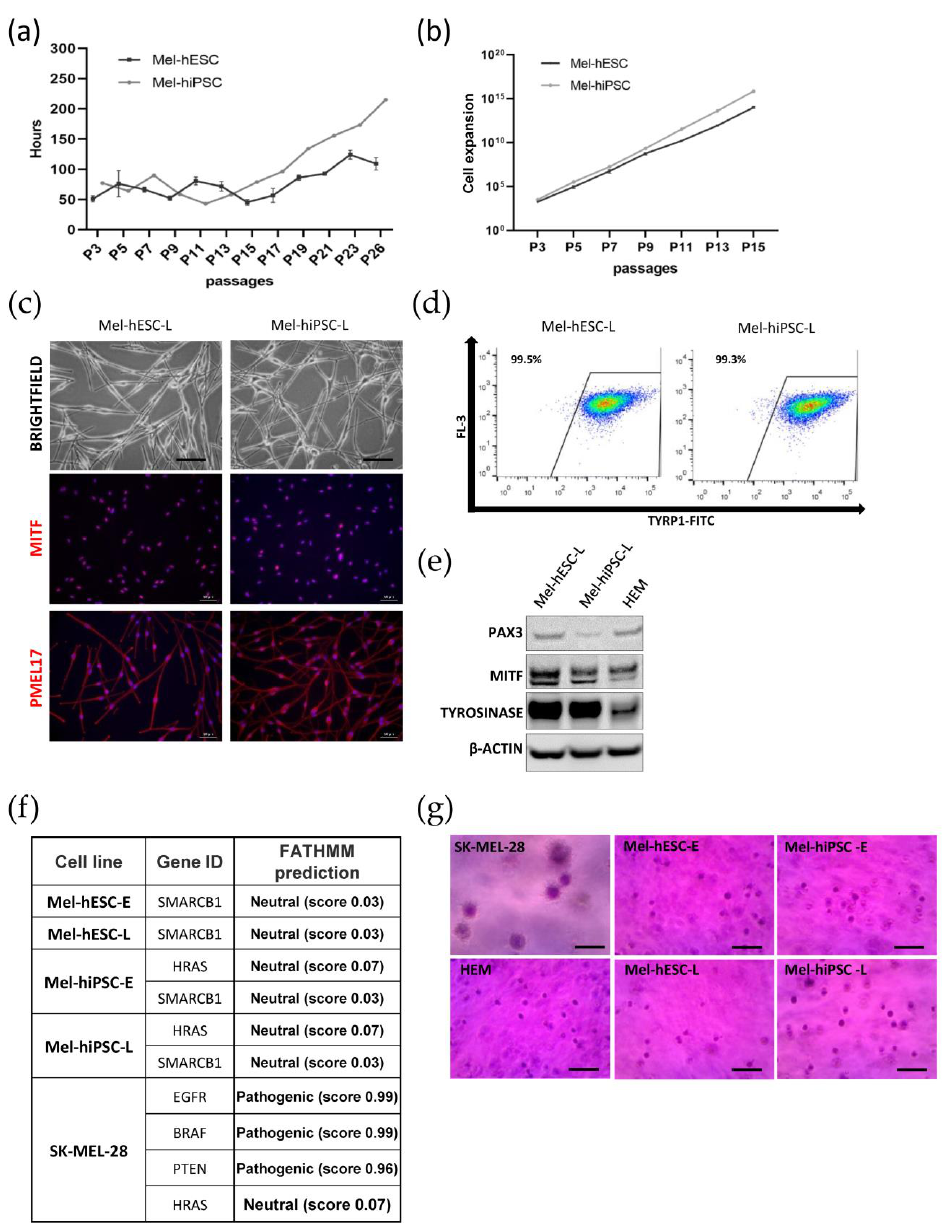
Figure 3. Long-term proliferation of hPSC-derived melanocytes. ( a ) Doubling time measurements during the growing phase of the Mel-hESC and Mel-hiPSC, from passage 3 (P3) to passage 26 (P26). ( b ) Cumulated cell expansion calculated from passage 3 (P3) to passage 15 (P15). For the next parts of the figure, Mel-hPSC early passages (Mel-hPSC-E) are defined from P3 to P15 and Mel-hPSC late passages (Mel-hPSC-L) are defined from P15 to P26. ( c ) Microscopy analysis and immunofluores- cence analysis of MITF, TYRP1, and PMEL17 in Mel-hESC-L and Mel-hiPSC-L. Scale bar is 50 µm.